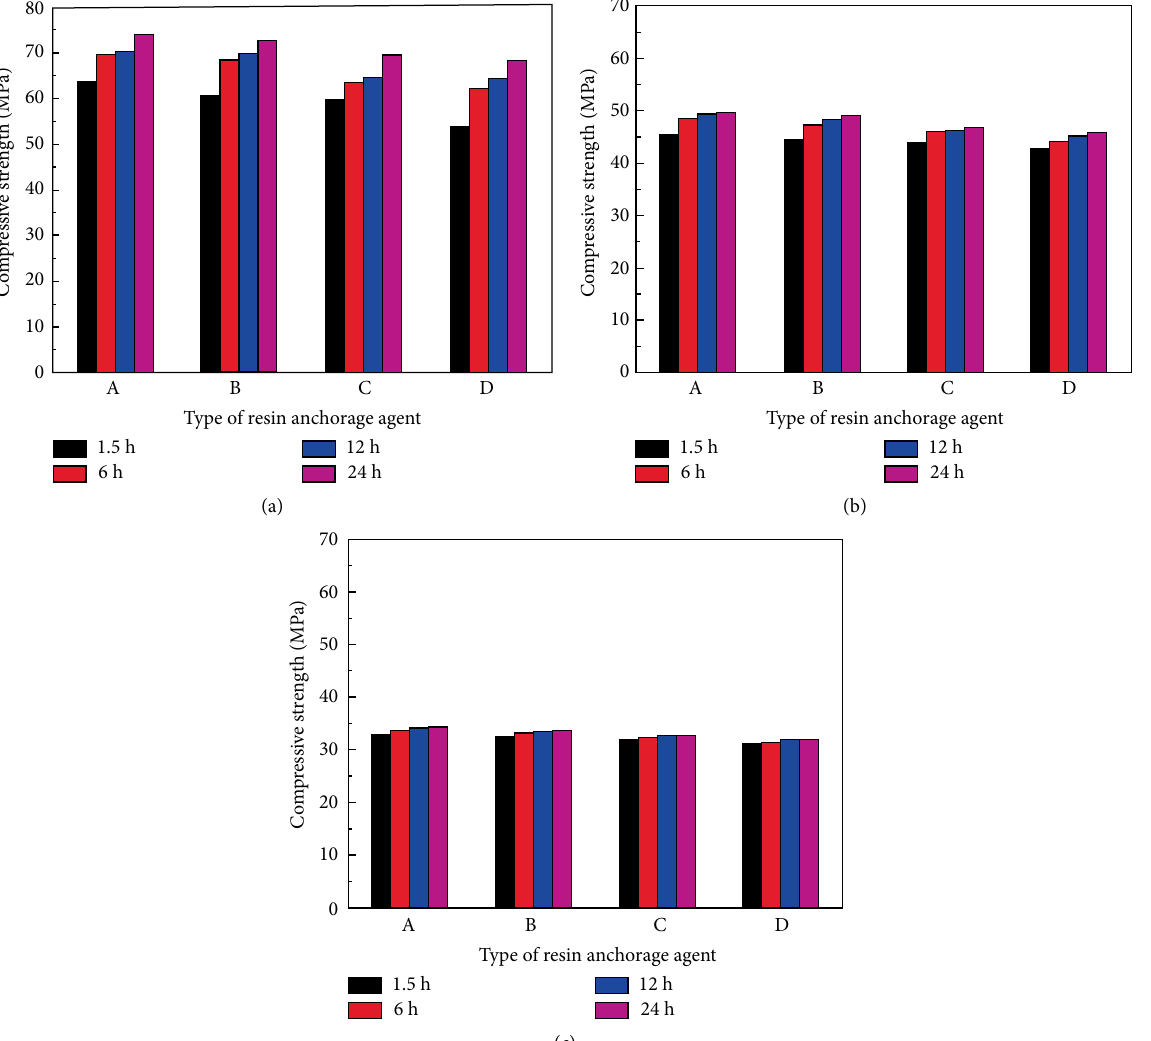
Figure 11: Column diagram of compressive strength of resin anchorage agent at different temperatures: (a) 20°C, (b) 50°C, and (c)